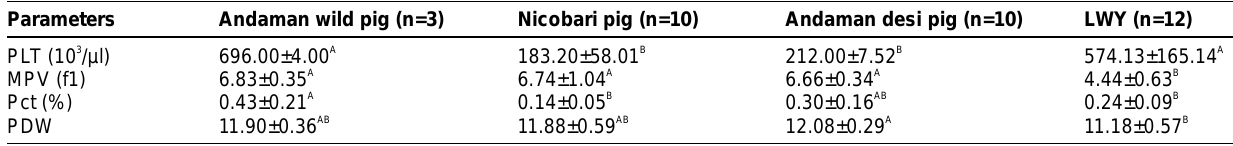
Values are presented as Mean±Standard Deviation A,B,C,D Values within the same row with different superscripts differ significantly (P<0.05). Table-3. Comparative thrombocytic parameters of different pig breeds of Andaman and Nicobar Islands Parameters